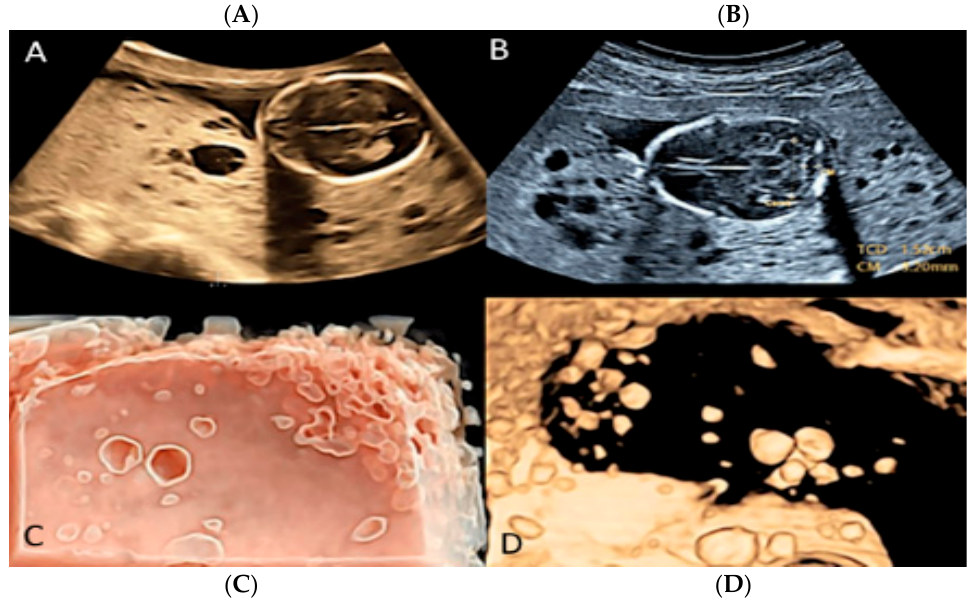
Figure 11. Placental with mesenchymal dysplasia at 15 weeks of gestation. Two-dimensional ( A , B ) and three-dimensional ultrasound ( C , D ) with HD-Live Silhouette™ and inversion mode displaying a characteristic large placenta with “grape-like”, multicystic changes.